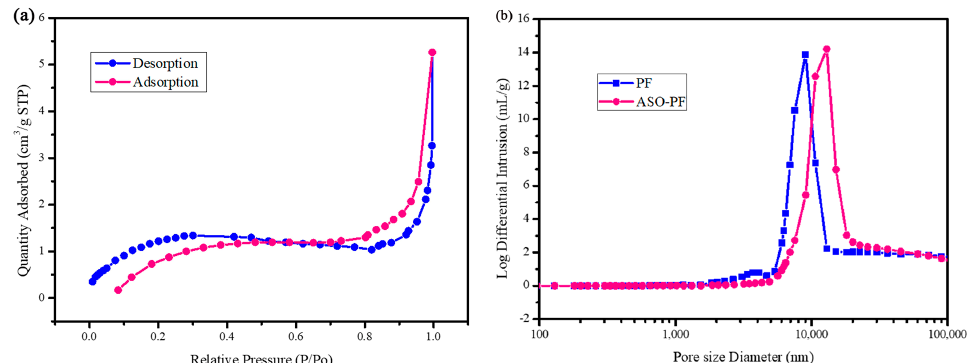
Figure 1. Scanning electron microscopy (SEM) images of PF ( a – c ) and ASO-PF ( d – f ) xerogels.